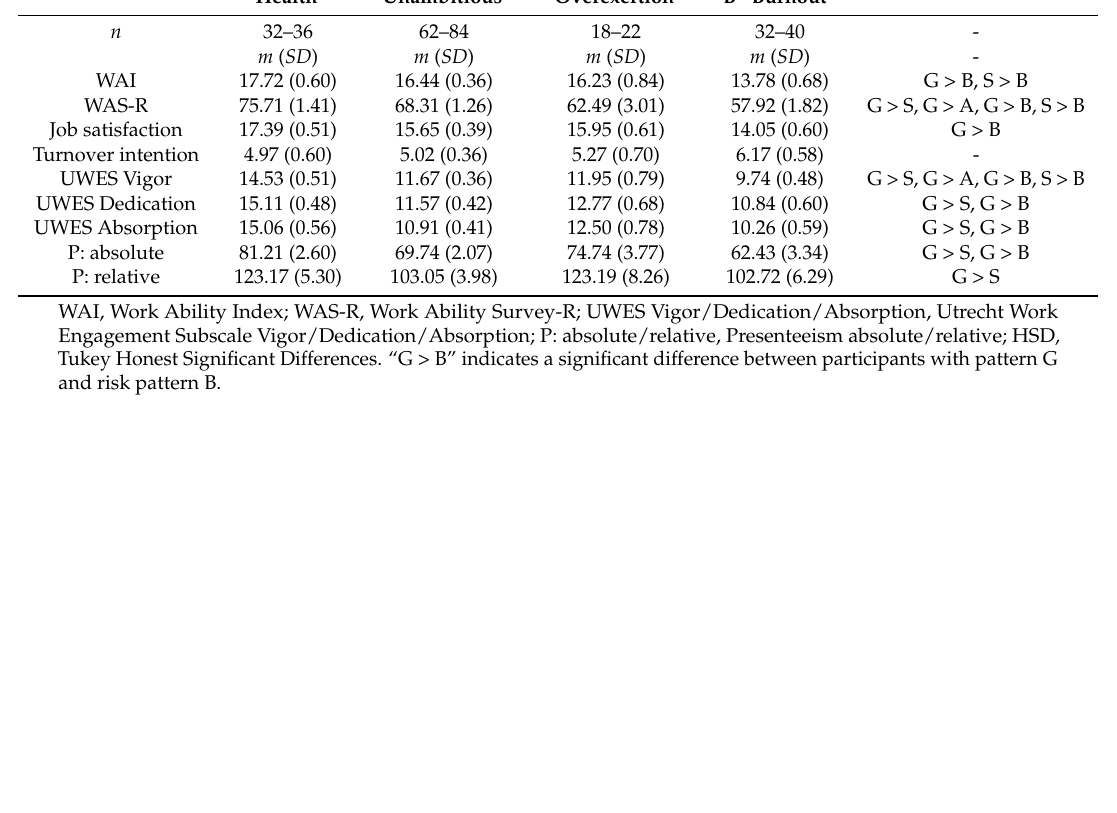
Table 4. Differences of work-related behavior and experience patterns (AVEM) in relevant other work-related variables.